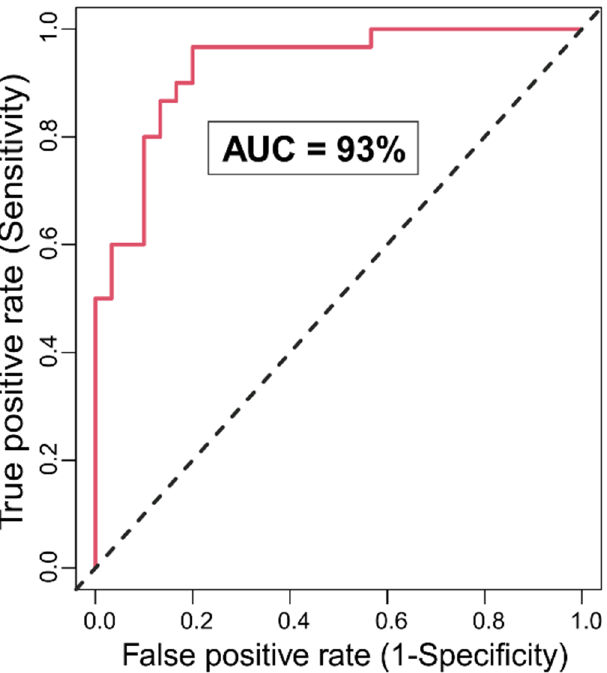
Figure 3. Receiver operating characteristic (ROC) curve for the RF model for different true positive rate (sensitivity) and false positive rate (1-specificity) are shown. The area under the ROC curve was 93%. (The further away the curve from the diagonal dashed line and the closer the swelling to the top left corner, the better the classification.)